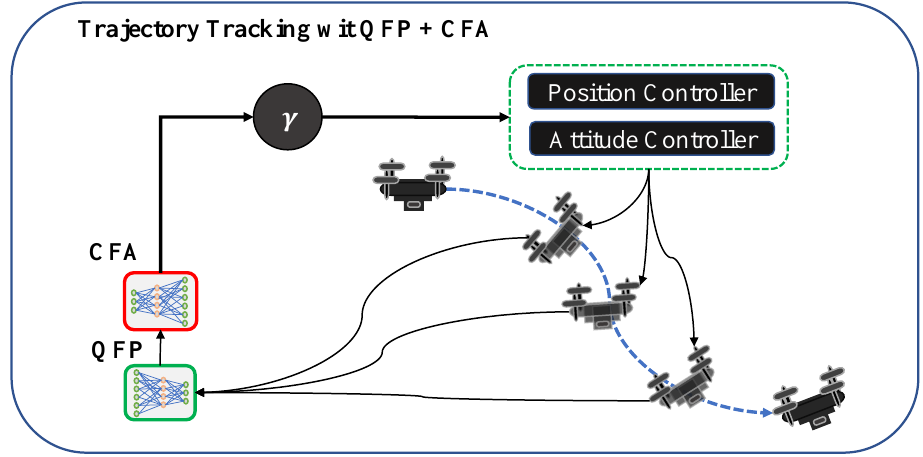
Figure 5. An illustration of trajectory tracking with the QFP+CFA model. At each time step, the QFP model predicts the next state of the quadrotor controlled by the PID, and the CFA model outputs a ratio γ to balance the position and attitude control